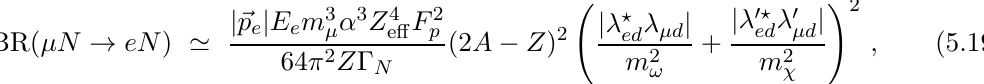
e conversion at tree-level in the doublet-singlet LQ